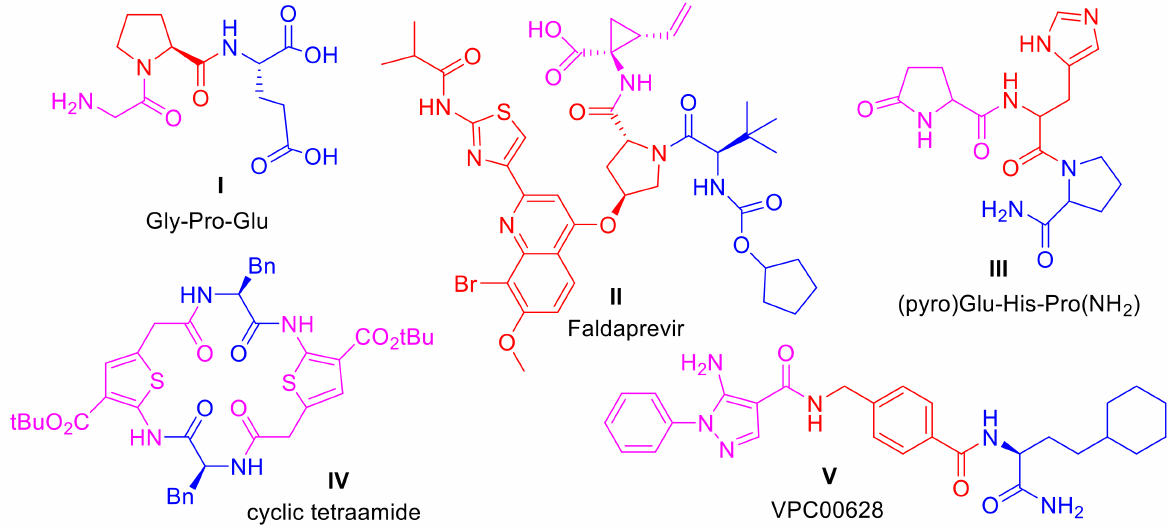
Figure 1. Examples of biologically active peptides derived from heterocyclic amino acids: Gly-Pro-Glu I , faldaprevir II , (pyro)Glu-His-Pro(NH 2 ) III , cyclic tetraamide IV , and VPC00628 V